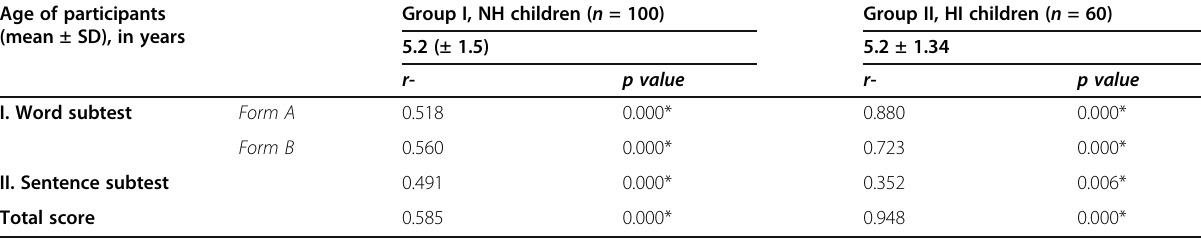
*Pearson correlation; p value is significant at <